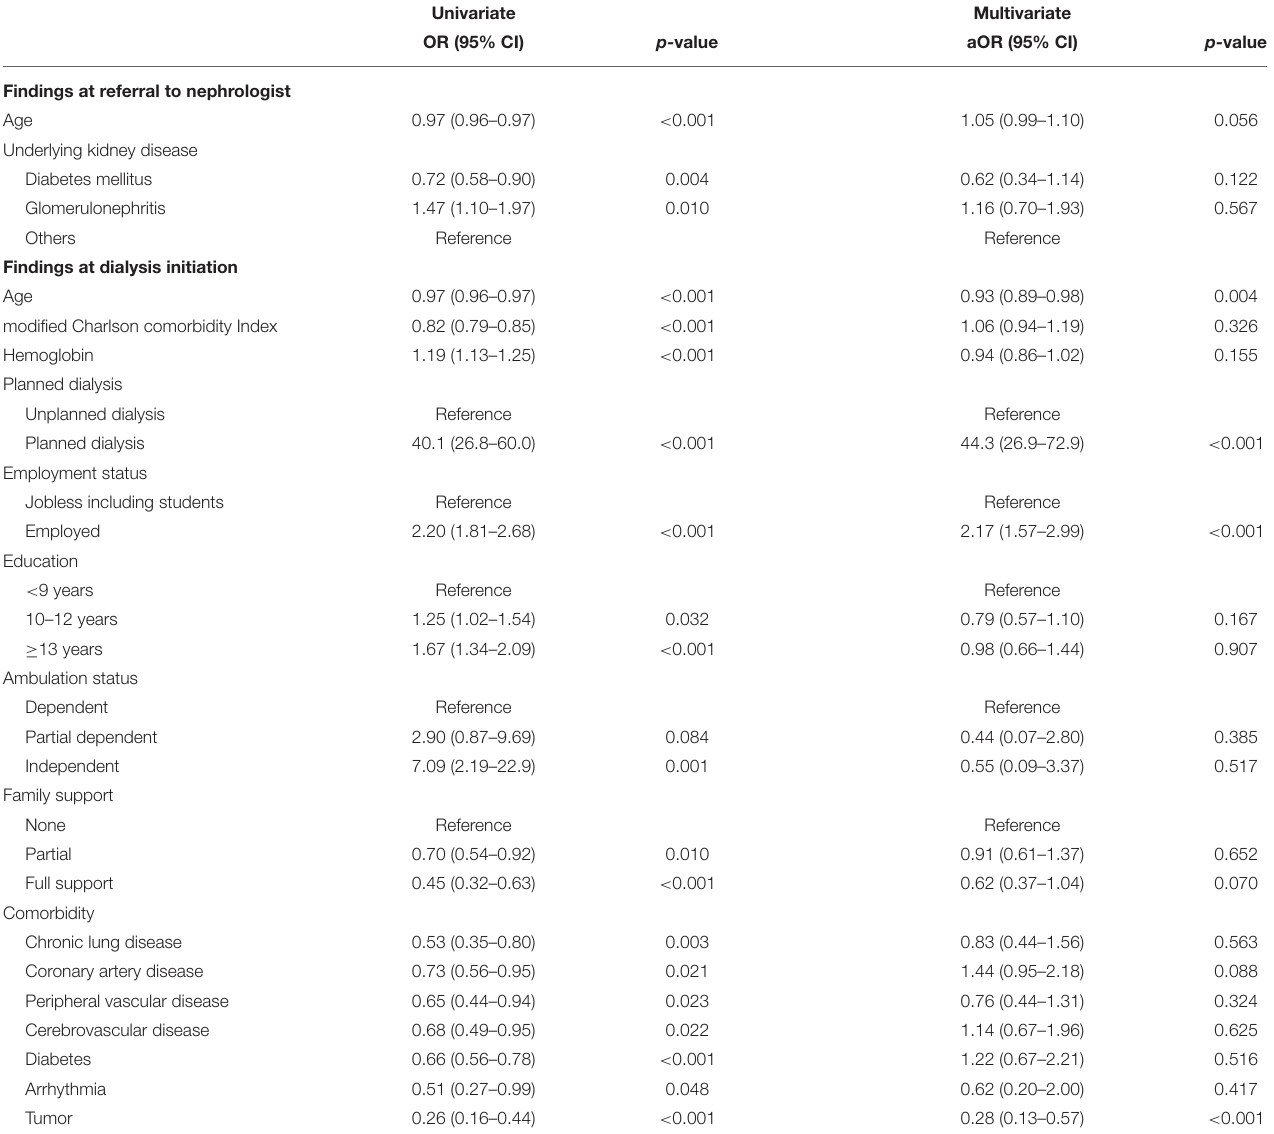
TABLE 1 | Logistic regression analysis of factors associated with selecting peritoneal dialysis for all